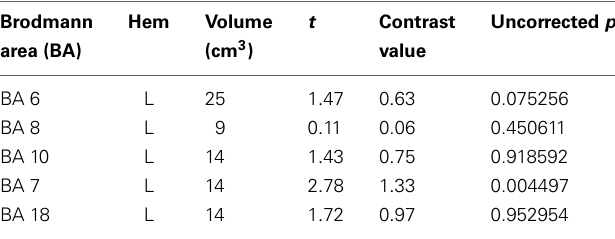
Table 5 | Structural ROI defined based on anatomical regions identified in previous studies of relational complexity or color